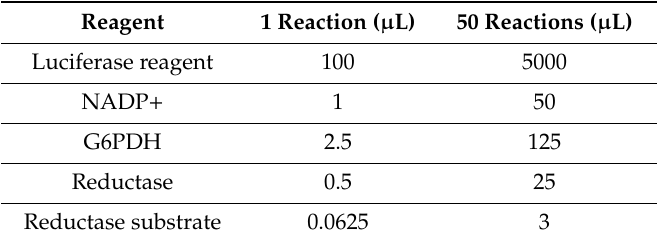
Table 1. Constituents of glucose-uptake